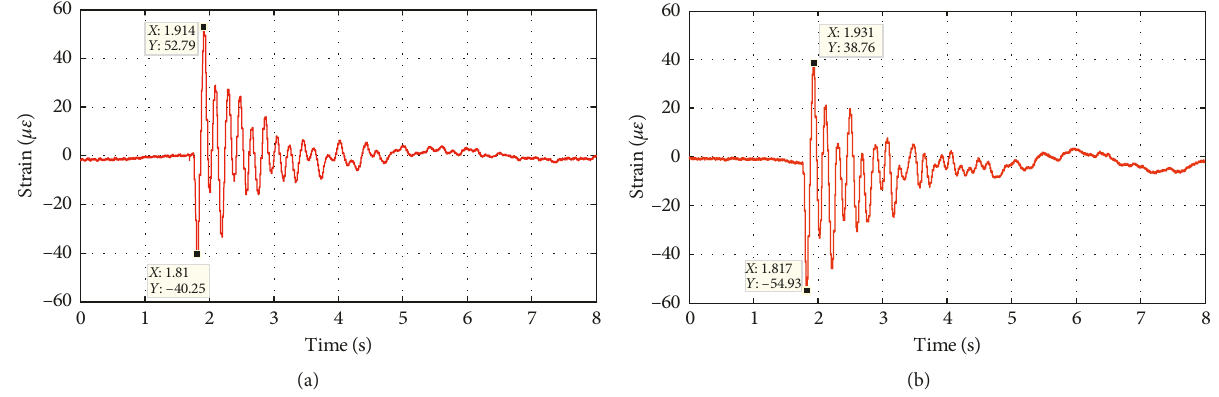
Figure 7: Stain measurement results of the ground deployment testing. (a) Sensor 1. (b) Sensor